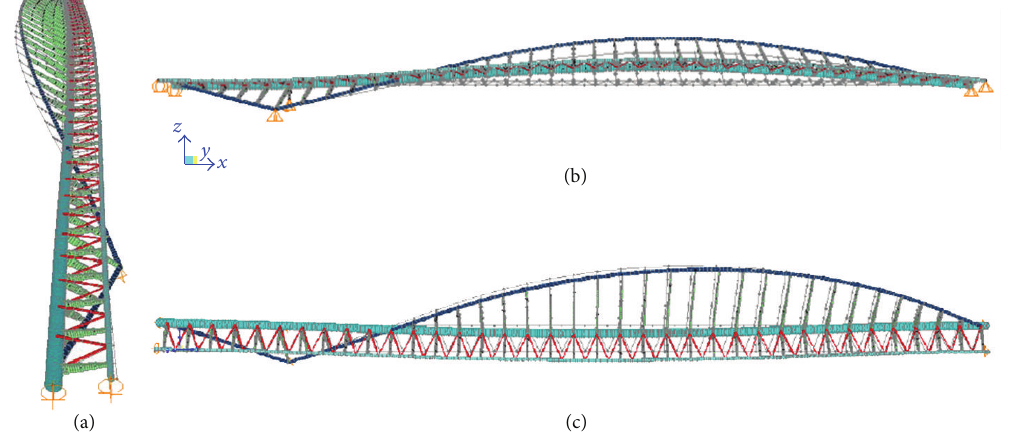
Figure 16: First vibration mode with 𝑓 = 0.84 Hz with predominant vertical movement: (a) front view; (b) from above; (c) lateral view.